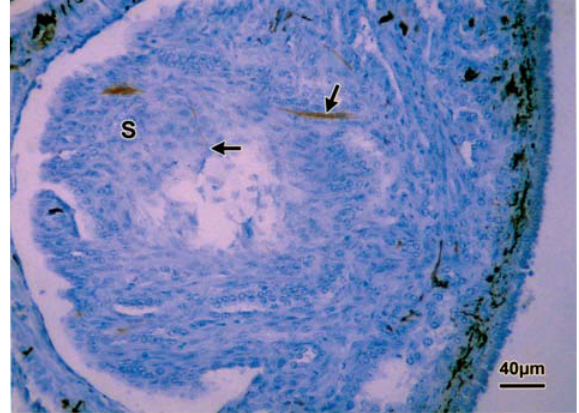
FIG. 6 Infiltration of an atretic previtellogenic follicle by con- nective tissue stroma (S) and NP immunoreactive nerve fibres